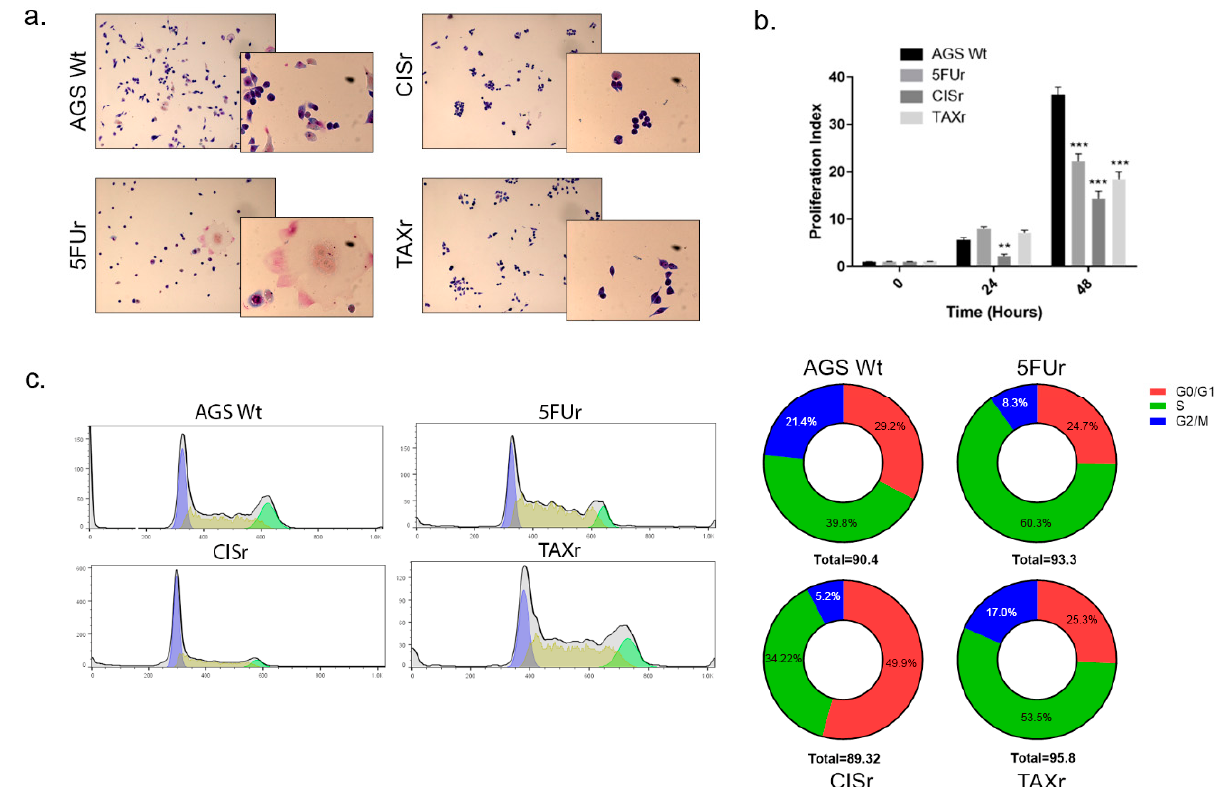
Figure 2. Characterization of Chemoresistant Cell Lines. ( a ) Images of AGS WT and chemoresistant cells. Cells were fixed and stained with Hematoxylin and Eosin. ( b ) Proliferation Index: fold expansion during cell culture (ratio of final cell count to starting cell count) as defined in ModFitLT. ( c ) Cell cycle profile was evaluated using FACS Canto II collecting 10,000 events per sample and analyzing using the FlowJo software. Cell cycle curves identifying the G0/G1, S and G2/M phases were plotted (left) and the area under the curves was analyzed and presented in pie charts (right). The total percentage of cells is indicative of the three phases analyzed, avoiding the sub-G0/G1 and the over-G2/M representing debris and apoptotic cells. Even if slightly different, the total percentage of events analyzed is not significant among the four cell lines. Data are presented as mean ± SD ( n = 3) ** p < 0.001; *** p < 0.0001 (Two-way ANOVA test).